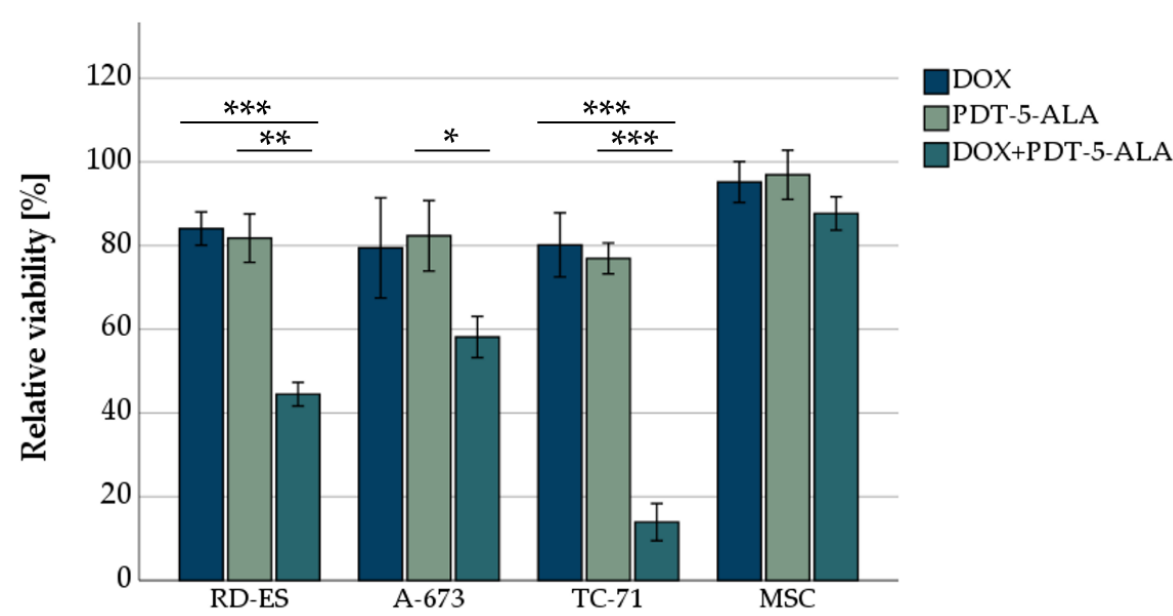
Figure 3. MTS-viability assessment of ES cell lines after DOX treatment and PDT exposure. For DOX, 15 nM was chosen for all three ES cell lines (RD-ES, A-673, TC-71) as well as MSCs. For the photosensitizer 5-ALA, concentrations adapted to the sensitivity of the cell line were chosen (0.15 mM RD-ES, 0.25 mM TC-71, 0.35 mM A-673, and MSCs). Mock-treated control was set to 100% viability. Error bars indicate the standard deviations (* p < 0.05, ** p < 0.01, *** p < 0.001 relative to other treat- ment). Abbreviations: 5-ALA — 5-aminolaevulinic acid; DOX — doxorubicin; ES — Ewing sarcoma;